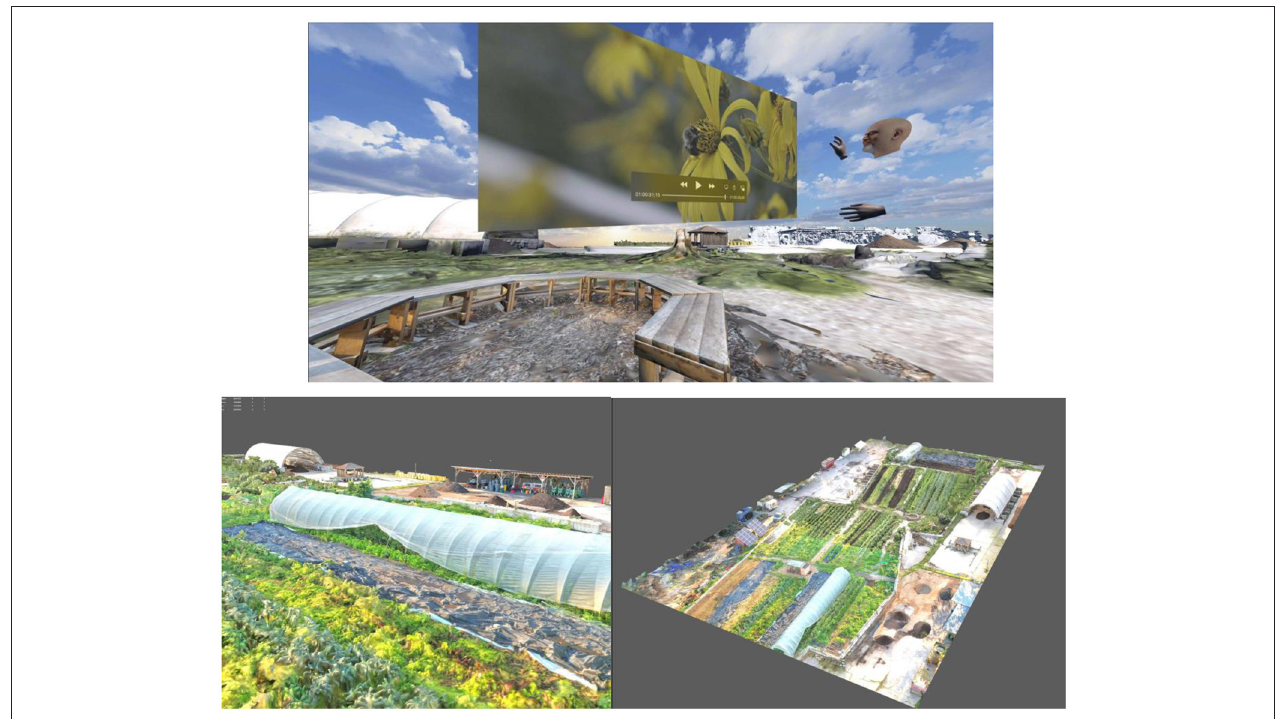
FIGURE 2 | Screenshots of our VR platform showing a user represented by an avatar interacting with an embedded video clip (top image). Aerial views of the 3D model of Red Hook Farm in Brooklyn, New York featuring solar panel arrays, processing shed, postharvest storage, composting area, herbal and medicinal plant garden, high tunnels for vegetable production, apiaries, chicken coop, and diversified perennial and annual crop